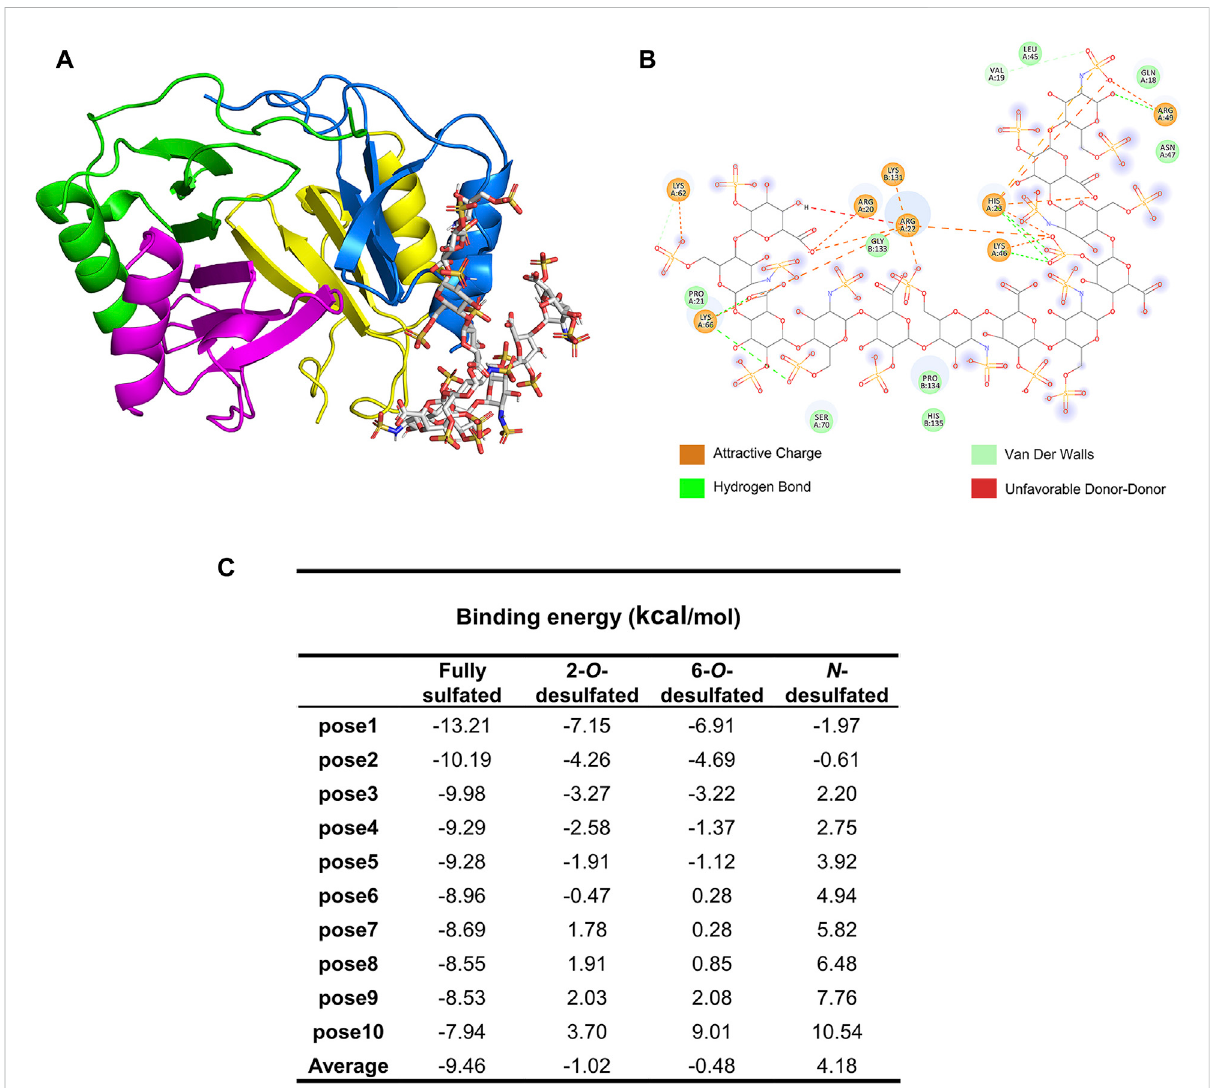
FIGURE 4 Molecular docking and modeling simulation of PF4 and HP dodecasaccharides. (A) The complex of the PF4 tetramer (PDB number: 1F9Q) and fully sulfated HP dodecasaccharide (PDB number: 1HPN) generated by AutoDock 4.2.6 and shown in Pymol. (B) The contributions of amino acid residues of PF4 and acidic groups of HP dodecasaccharide to the binding and the types of interactions involved in the binding. (C) Binding energy of different HP dodecasaccharides to